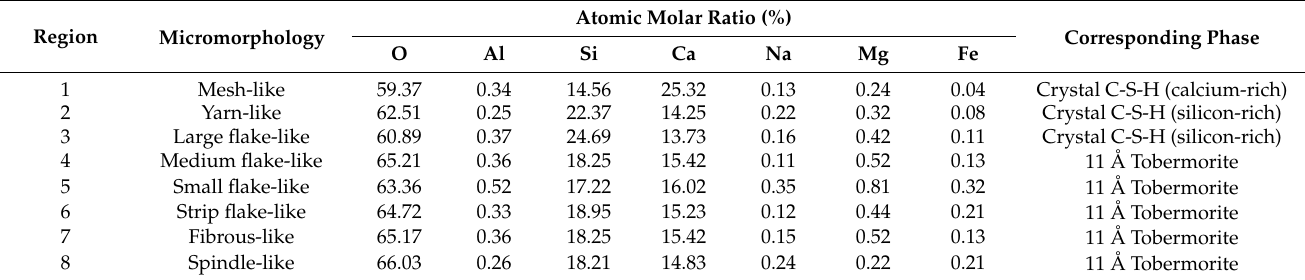
Table 2. EDS analysis and corresponding phase of hydrothermal synthesis at different hydrothermal synthesis